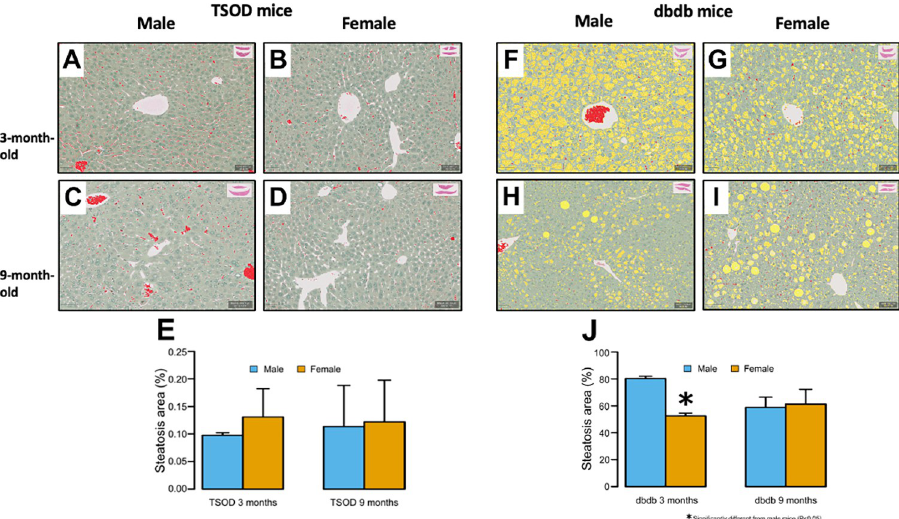
Fig 3. Image analysis for quantification of steatosis. A-E) There is no significant sex difference in the frequency of steatotic area in 3- and 9-month-old TSOD mice (one-tailed t-test for young mice and two-tailed t-test for old mice). F-J) The frequency of steatotic area is significantly higher in 3-month-old male db/db mice than females (one-tailed t- test); however, significant sex differences are not observed at 9 months (two-tailed t-test). (A-D,F-I: Original magnification ×